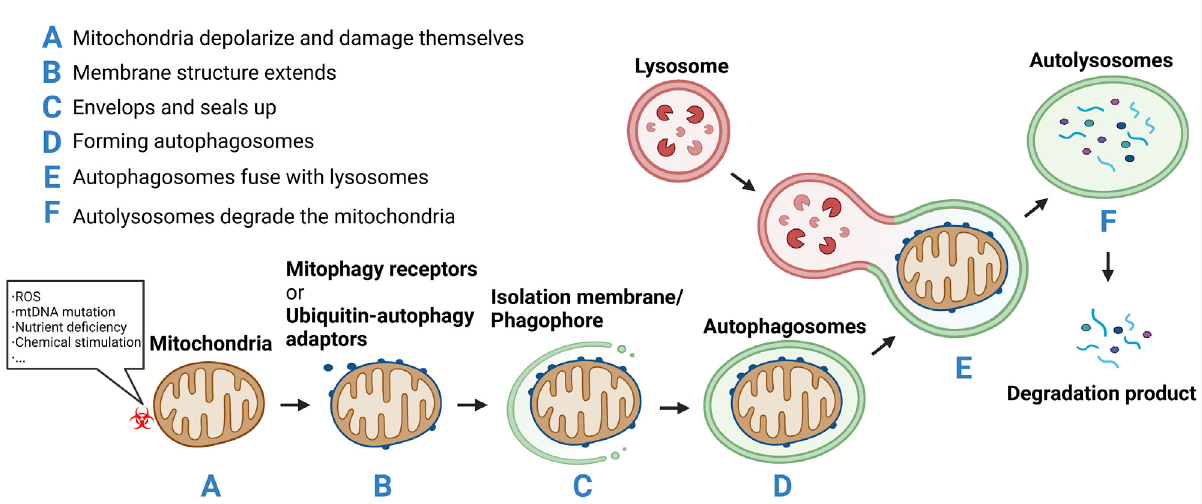
FIGURE 2 (A) Mitochondria depolarize and damage themselves in response to various stimuli such as reactive oxygen species (ROS), nutrient de fi ciency, chemical stimulation, and mtDNA mutation. (B) Mitochondria membrane structure extends. (C) Envelops and seals up the mitochondria to be removed. (D) Forming autophagosomes. (E) The autophagosomes fuse with lysosomes to form autolysosomes. (F) The autolysosomes degrade the